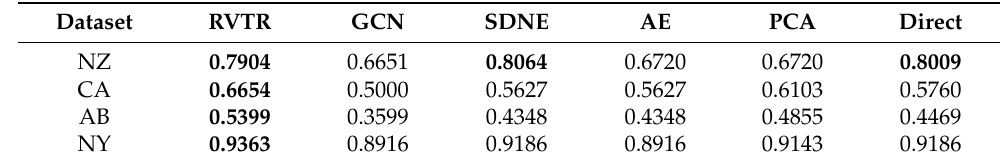
Table 7. The test results in different datasets (model trained on the Australia dataset and tested on other